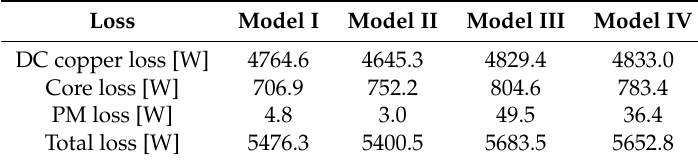
Table 4. Comparison of losses in different